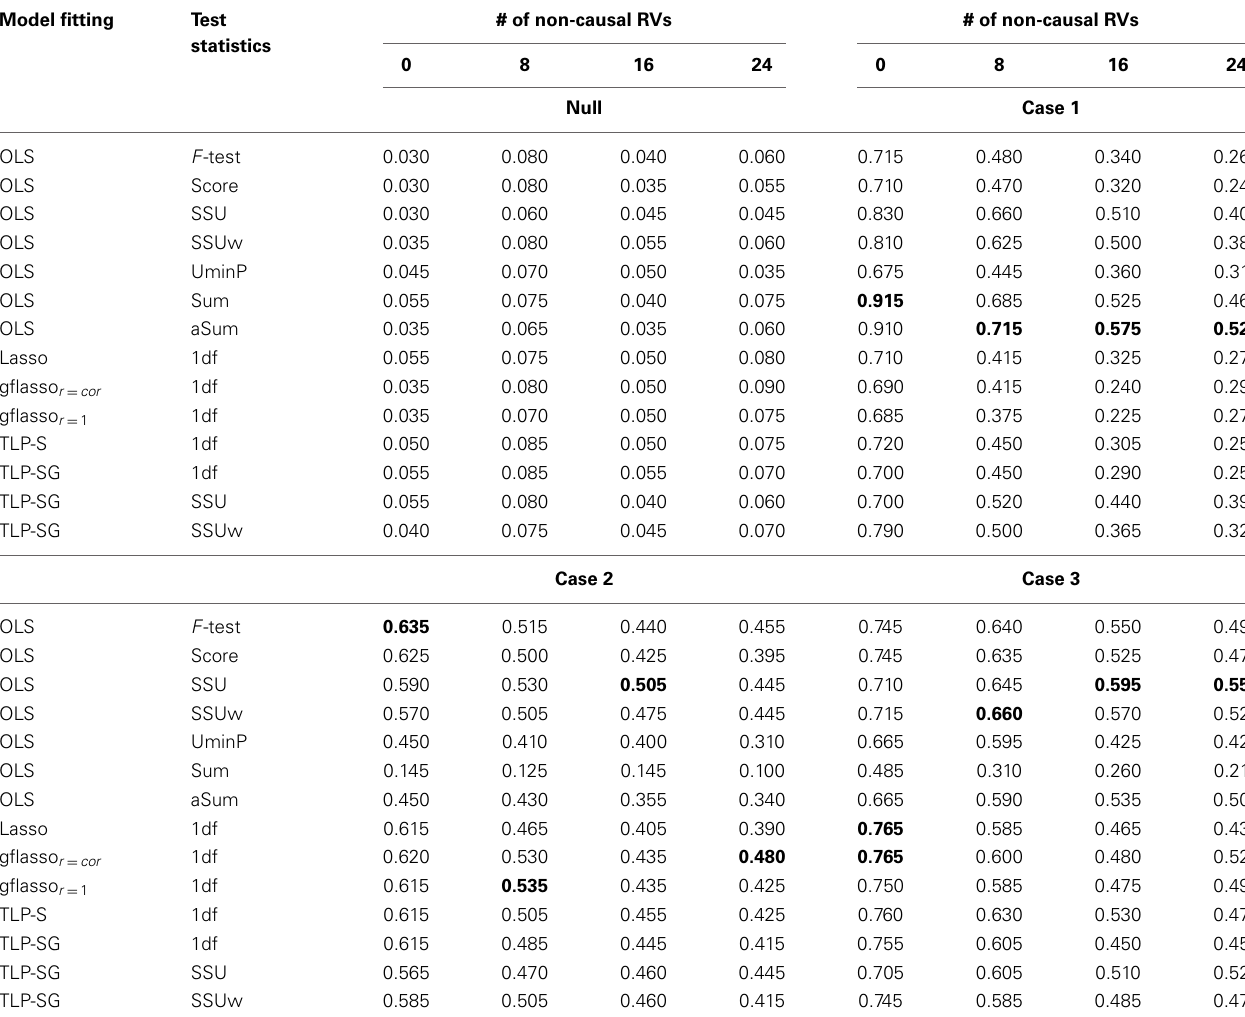
Table 1 | Empirical Type I error and Power at the nominal level α = 0 . 05 based on 200 replicates for the RVs only set-ups with six causal RVs and a varying number of non-causal